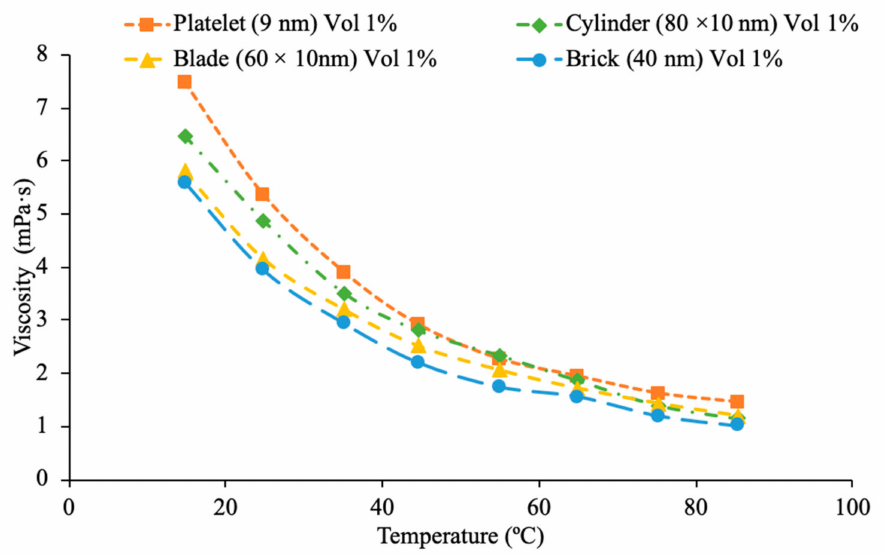
Figure 26. Viscosity versus temperature for different shapes of nanoparticles (platelets, cylinders, blades, and bricks) at 1% volume of Boehmite Alumina (AlO (OH)) nanofluid with 50% ethylene glycol (EG) and 50% water using measurements [67].